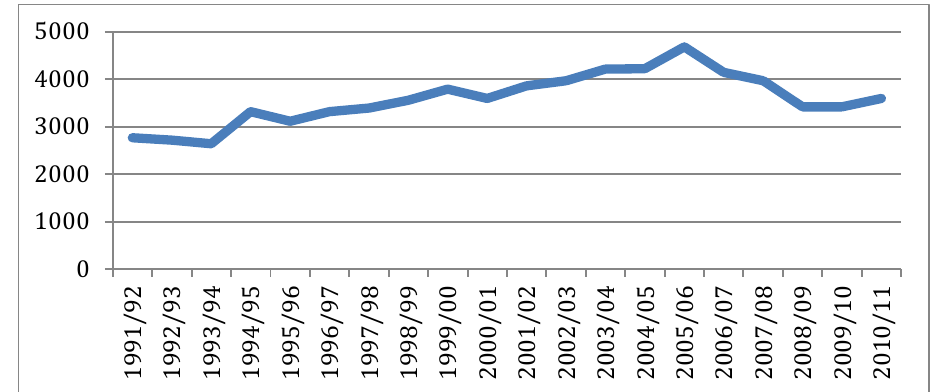
Figure 3. University diplomas in engineering in Sweden 1991–2011. Reprinted from Statistics Sweden, the Education Register and the Occupational Register.